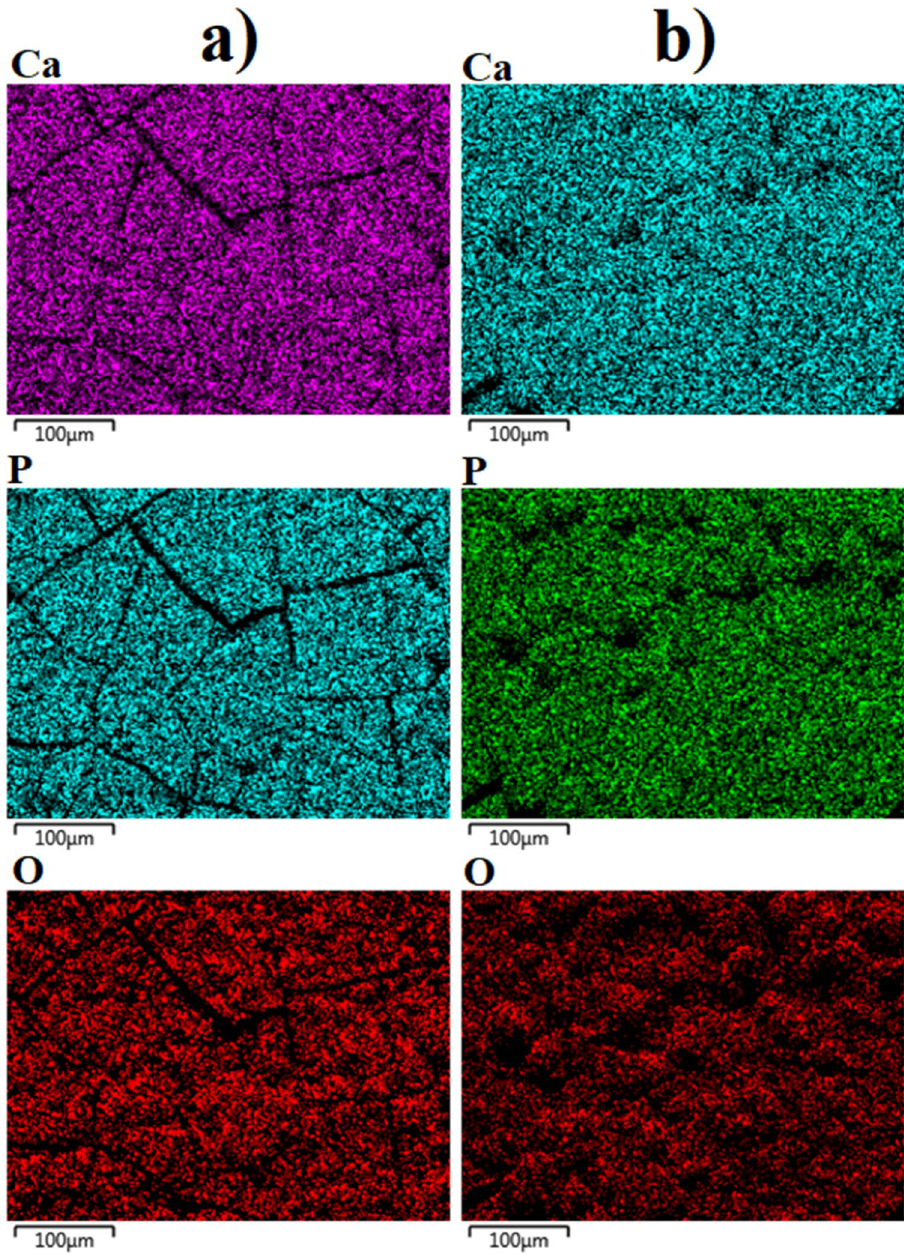
Figure 8. EDX-mapping analysis images of the coatings at post-immersion in SBF: ( a ) the MAO and ( b ) chitosan-based MAO surfaces.